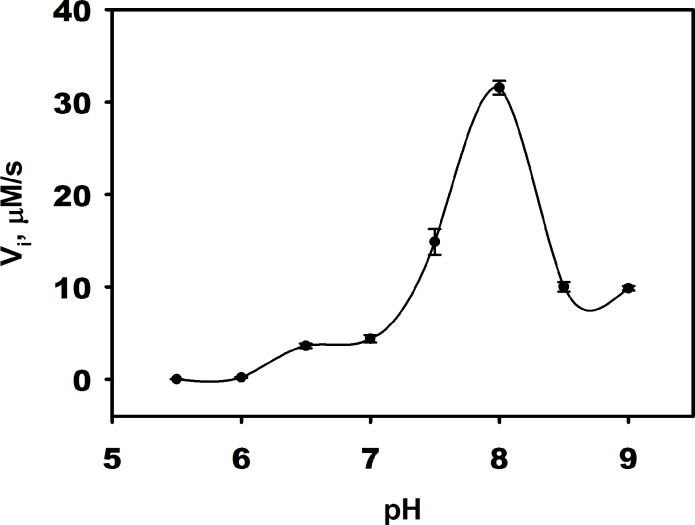
The pH dependence of DddW lyase activity.The optimal pH was determined by comparing the initial velocities (Vi) of reactions containing 2 μM apo-DddW, 2 μM Fe(II), and 10 mM DMSP in varying buffer solutions. The buffers used are as follows: 50 mM MES 20 mM NaCl (pH 5.5, 6.0, 6.5), 50 mM HEPES 20 mM NaCl (pH 7.0, 7.5, 8.0), 50 mM Tris-HCl 20 mM NaCl (pH 8.5, 9.0).